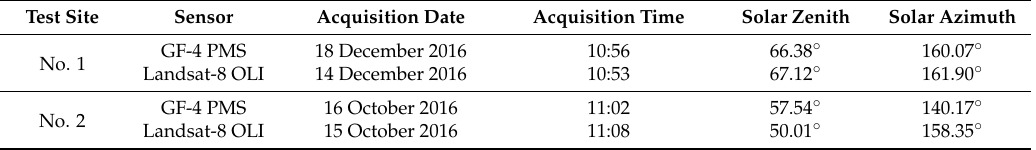
Figure 12. RGB composite images of overlapping regions of two pairs of PMS and OLI images: ( a ) PMS image of test site No. 1; ( b ) OLI image of test site No. 1; ( c ) PMS image of test site No. 2; ( d ) OLI image of test site No. 2. The four subfigures have the same north arrow and scale, which are marked in the upper left corner of the figure. Table 4. Details of the pairs of the GF-4 PMS and Landsat-8 OLI